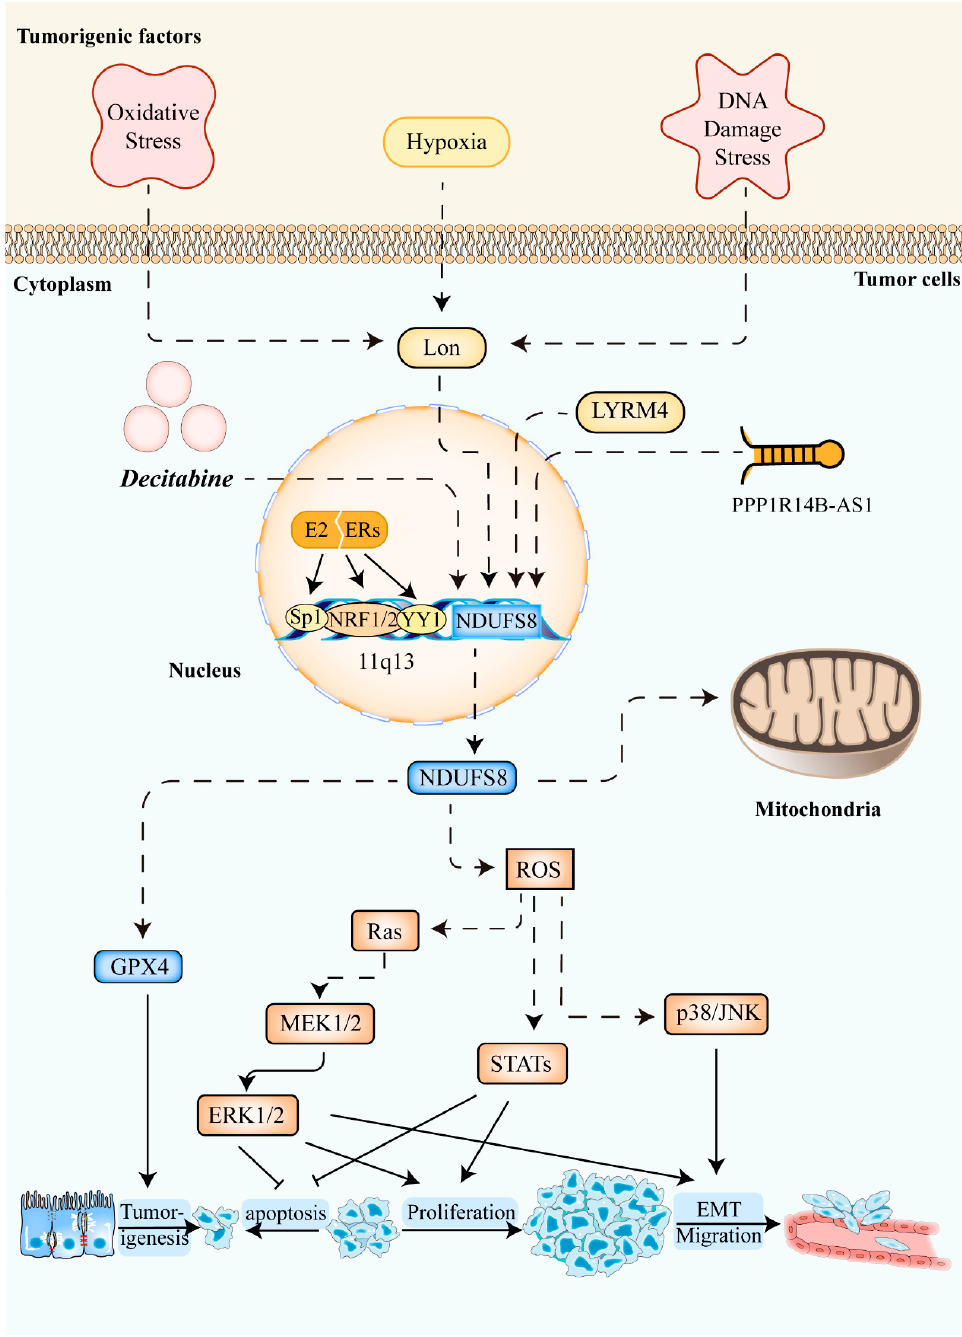
Figure 2. The roles of NDUFS8 in cancers. Several cancerogenic factors, such as oxidative stress, hypoxia, and DNA damage stress upregulate the level of mitochondrial Lon. Then, the elevated expression of NDUFS8 via the mitochondrial Lon caused an increased level of ROS in mitochondria [62]. Increased ROS concentration in tumor cells improves cell survival, proliferation, transformation, and migration through the activation of Ras-ERK1/2 signaling [78], STATs, and/or p38/JNK [62]. Meanwhile, the expression of NDUFS8 shows a strong positive correlation with GPX4 expression linked to tumorigenesis [79]. Moreover, induced by the E 2 /ER pathway [80], the general transcription factors NRF1/2, Sp1, and YY1 can activate the transcription of NDUFS8 . LYRM4 [81], long non-coding RNA PPP1R14B-AS1 [82], and decitabine [83] can also increase NDUFS8 expression in some cancer cells. Abbreviations: NDUFS8: NADH:ubiquinone oxidoreductase core subunit S8; ROS: Reactive Oxygen Species; GPX4: Glutathione peroxidase 4; EMT: epithelial–mesenchymal transition;